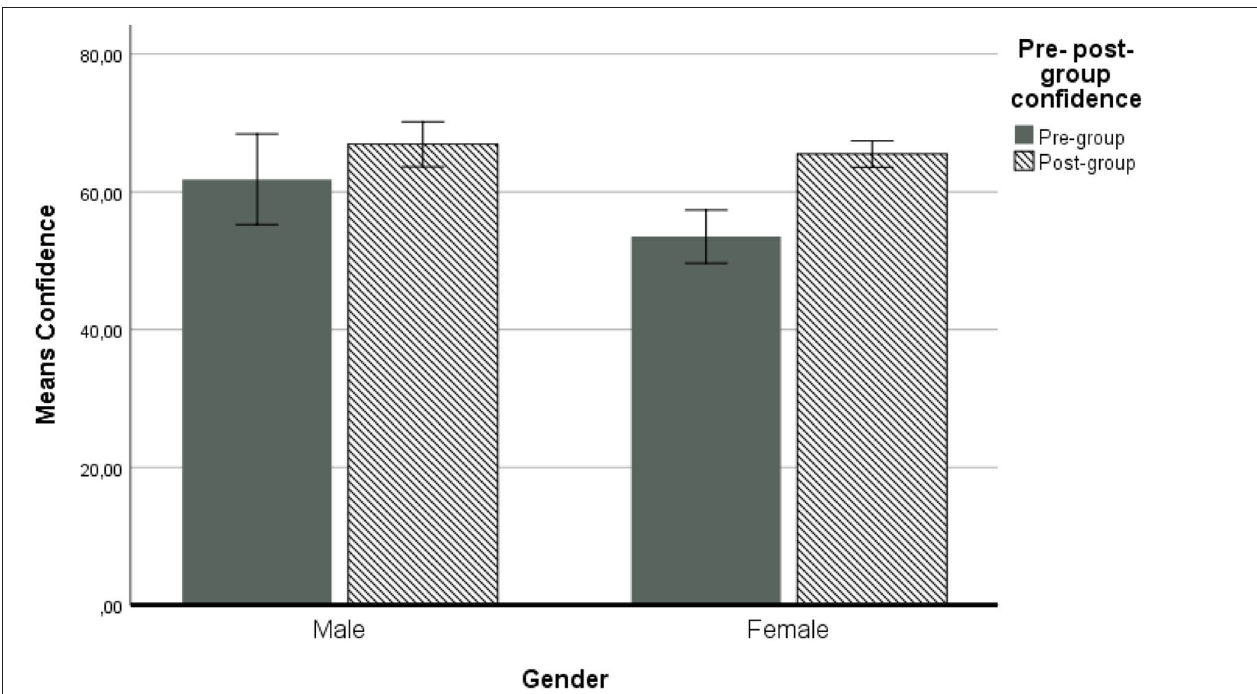
FIGURE 4 | Gender differences in confidence for pre- and post-group discussion. Covariates appearing in the model are evaluated at the following values: Age = 20.8095. AVGConGR = 66.5346. NFC = 3.5760. Error bars: 95% CI.